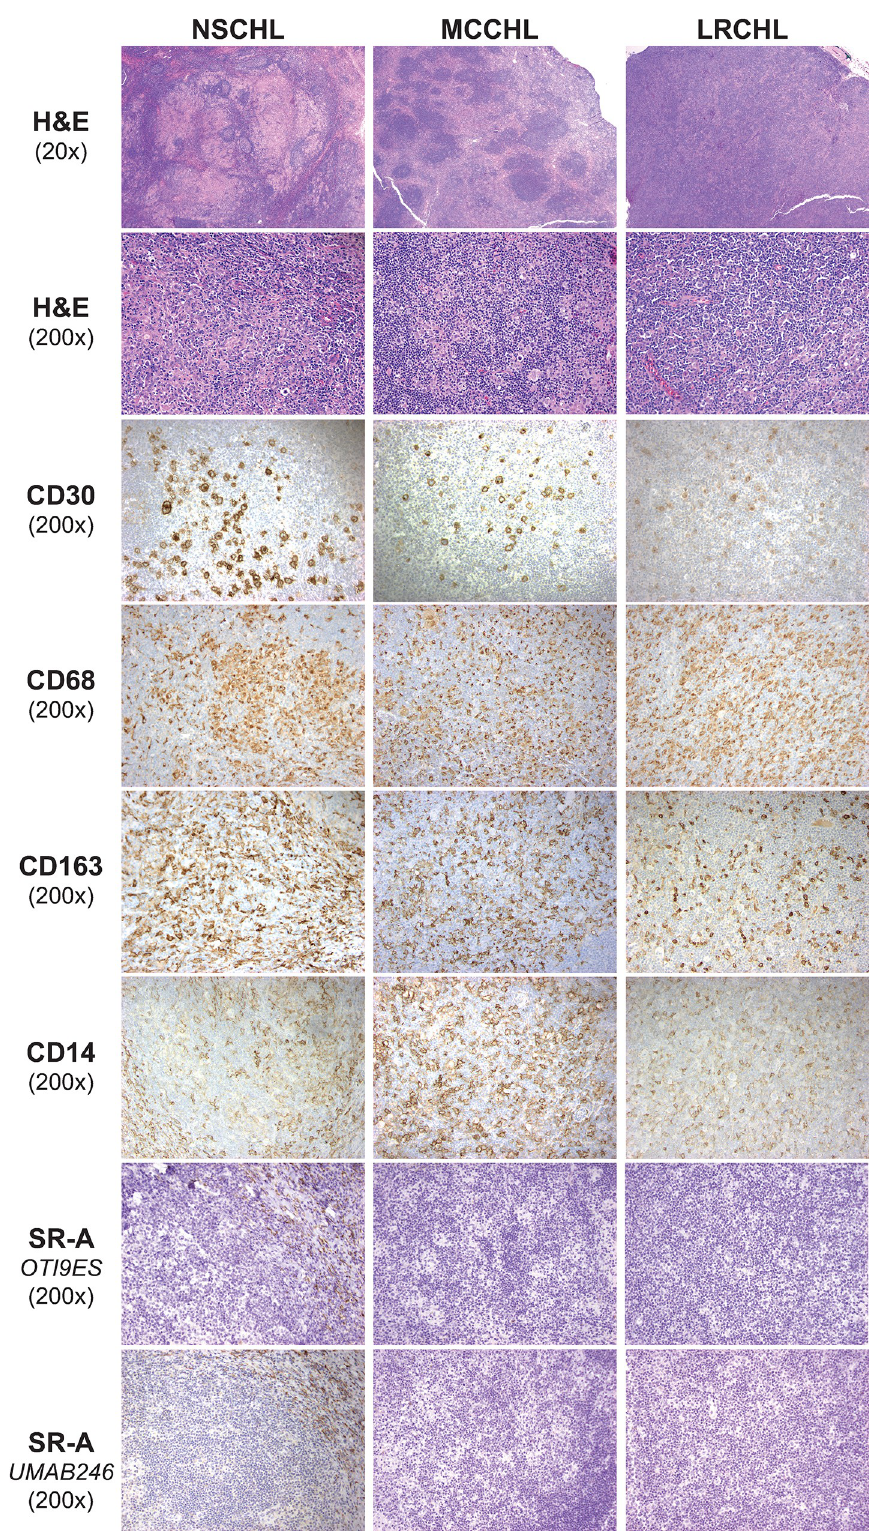
Fig 1. Expression pattern of monocyte/macrophage markers in nodal CHL. Shown are hematoxylin and eosin (H&E) and immunostaining patterns of different cellular markers in FFPE sections from representative CHL